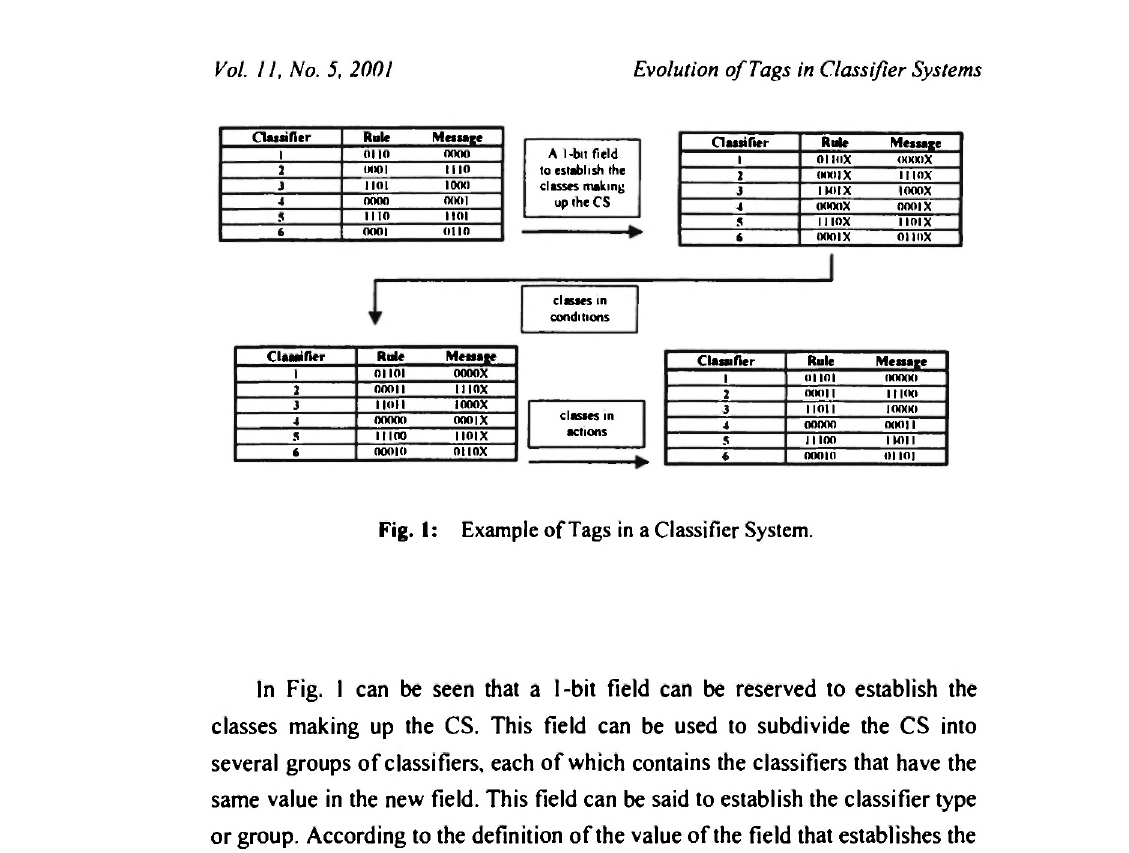
Fig. 1: Example of Tags in a Classifier